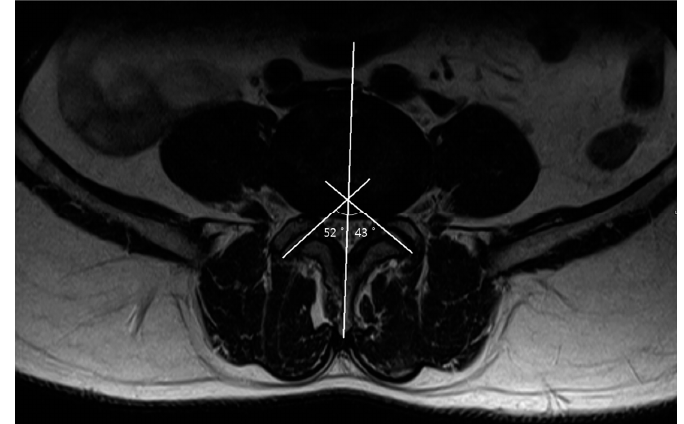
Figure 1. Measurement of the facet angle and facet tropism at L4–5. The facet angles are the angles between the line drawn through the midsagittal plane of the vertebra and the lines through each facet joint tangential to the superior articular process. The facet angle difference was calculated as the difference between the right and left facet angle.